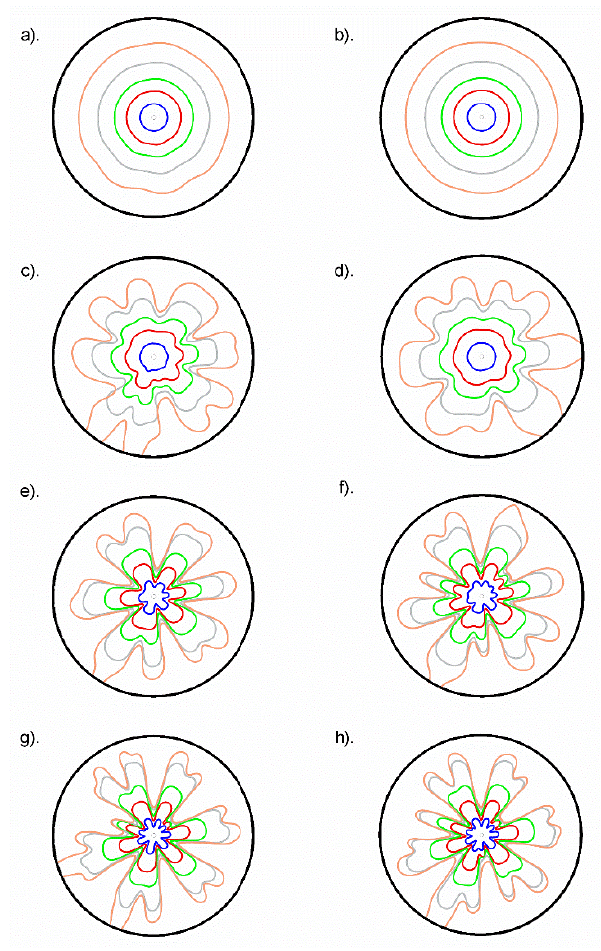
Figure 4. Temporal evolution of fingering for Darcy’s model (left column) and modified Darcy’s model (right column) for Re = 2.2 × 10 − 4 and Pe = 0.145 at different times: t = 30 s (blue), t = 120 s (red), t = 250 s (green), t = 500 s (grey), and t = 900 s (orange). Values are changed with rows as R = 2 for ( a , b ), R = 4 for ( c , d ), R = 6 for ( e , f ) and R = 8 for ( g , h ).